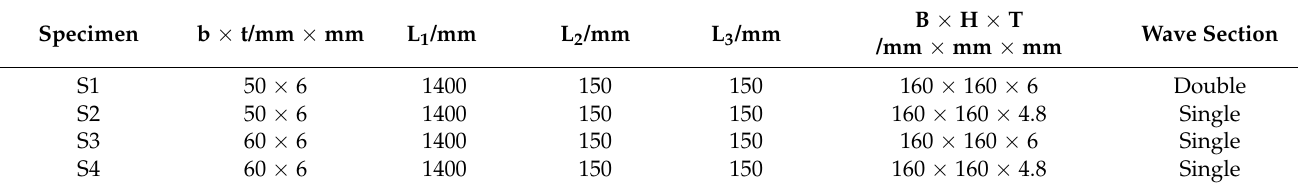
Table 1. Parameters of the